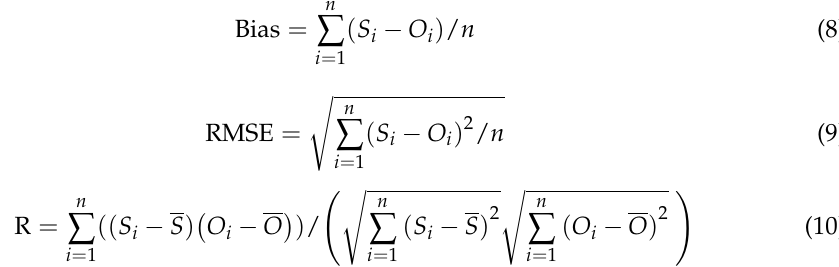
Table 3. S-HSP-(parameter of salinity effect) sensitivity experiments. Experiment Model Setting S-HSP- α Same as S-HSP except that albedo was set to that in S-NL Same as S-HSP except that the parameter of the light extinction S-HSP- η 0 coefficient η 0 was set from 2 × 1.1925 to 1.1925 as in S-NL Same as S-HSP except that the fraction of absorbed surface solar S-HSP- β radiation β was set from 0.6 to 0.5 as in S-NL Same as S-HSP except that the ratio of the saturated vapor S-HSP-Rsvp pressure Rsvp over the saline water to that over the fresh water in Equation (2) was set to 1 as in S-NL Same as S-HSP except that the temperature of the maximum S-HSP-Tmaxd density Tmaxd was changed from minus to 3.98 ◦ C as in S-NL Same as S-HSP except that the freezing temperature Tf was S-HSP-Tf changed from − 12.65 ◦ C to 0 ◦ C as in